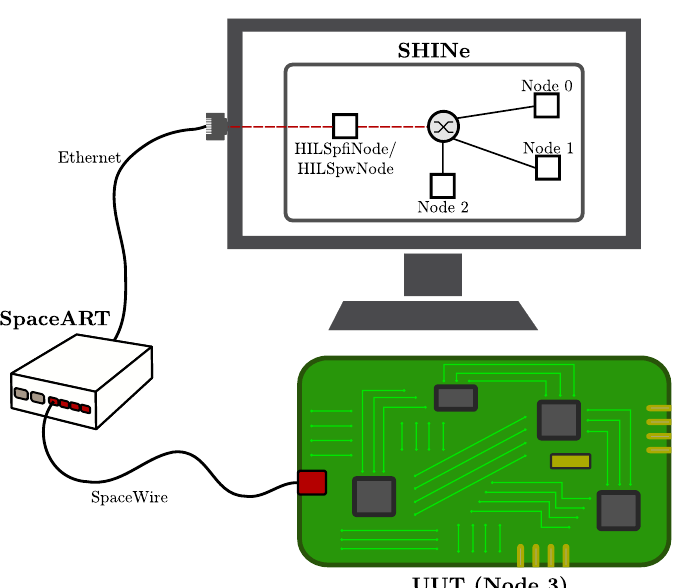
Figure 8. Hardware-in-the-Loop (HIL) configuration with Simulator for HIgh-speed Network (SHINe) connected with SpaceART and the Unit Under Test